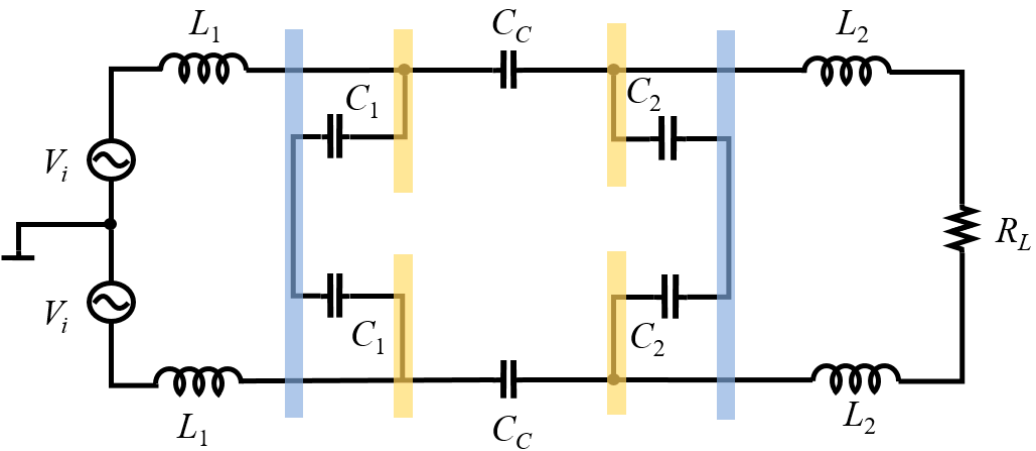
Figure 2. Equivalent circuit schematic for S-CPT.